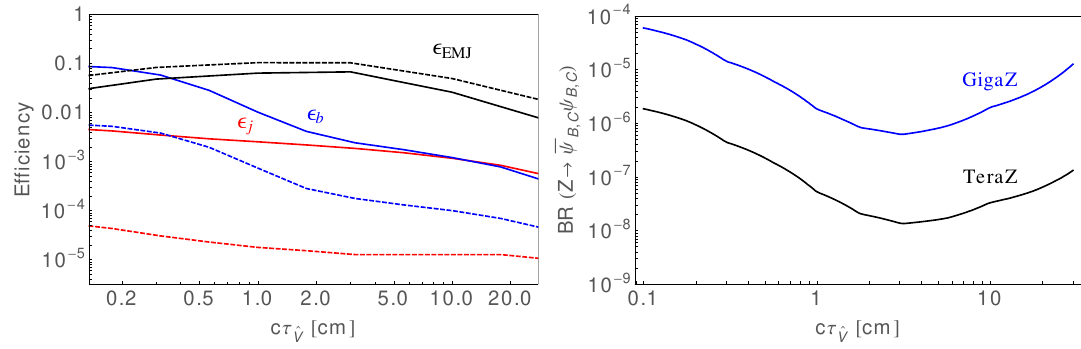
Figure 10 . Left: Emerging jet signal e(cid:14)ciency (black), b -jet misidenti(cid:12)cation rate (blue) and light-jet misidenti(cid:12)cation rate (red) as function of the target c(cid:28) ^ Solid curves correspond to the requirements N track (cid:21) 5 and 0 or 1 lepton tracks. Dashed curves correspond to N track (cid:21) 3 and (cid:21) 2 lepton tracks. Right: Projected 95% CL constraints on the Z branching ratio to the hidden